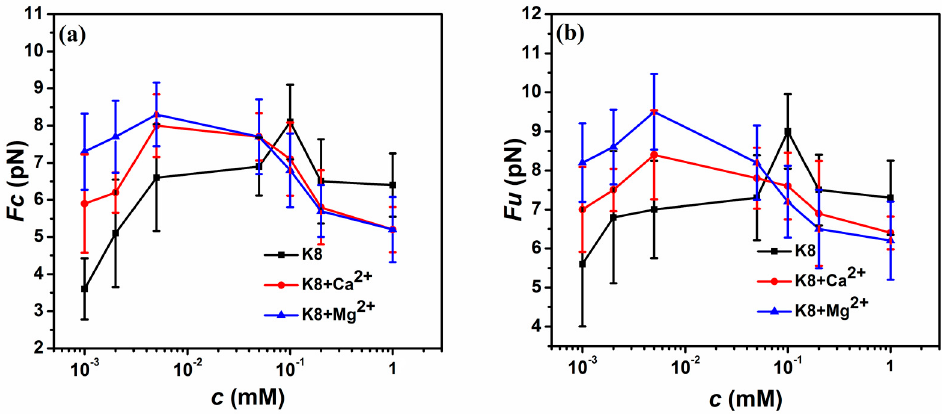
Figure 7. F C and F U of DNA in various solvent condition measured by MT. ( a ) F C of DNA in different concentration of K8 (black square) or K8 + 3 mM CaCl 2 (red point) or K8 + 3 mM MgCl 2 (blue triangle). ( b ) F U of DNA in different concentration of K8 (black square) or K8 + 3 mM CaCl 2 (red point) or K8 + 3 mM MgCl 2 (blue triangle).